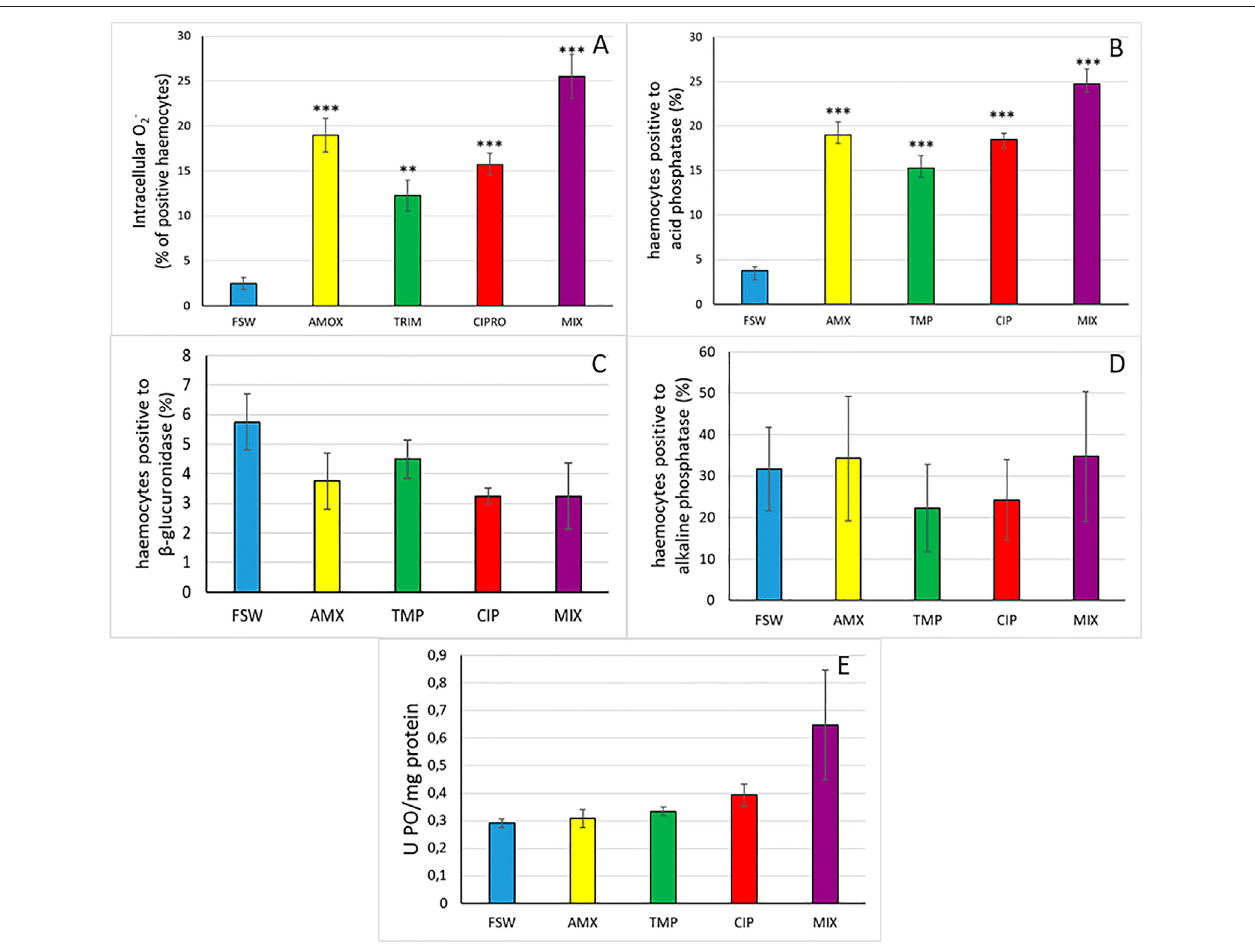
− production. (B) Percentageofhaemocytespositivetoacidphosphatase FIGURE2|(A) Percentageofhaemocyteswithblueprecipitateofformazan,denotingO 2 activity. (C) Percentage of haemocytes positive to β -glucuronidase activity. (D) Percentage of haemocytes positive to alkaline phosphatase activity. (E) Phenoloxydase activity in haemocytes. Asterisks denote signi fi cant differences with respect to controls (FSW): * p < 0.05, ** p < 0.01, *** p < 0.001.